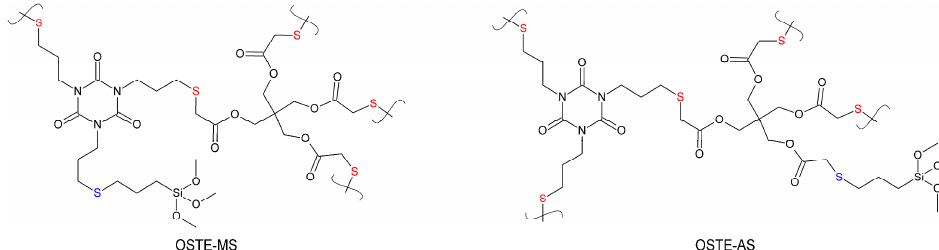
Figure 1. The silane-containing fragments of OSTE-MS and OSTE-AS polymers. The sulfur bridges between monomer fragments are indicated in red. The sulfur bridges between monomer fragments and silanes are indicated in blue.